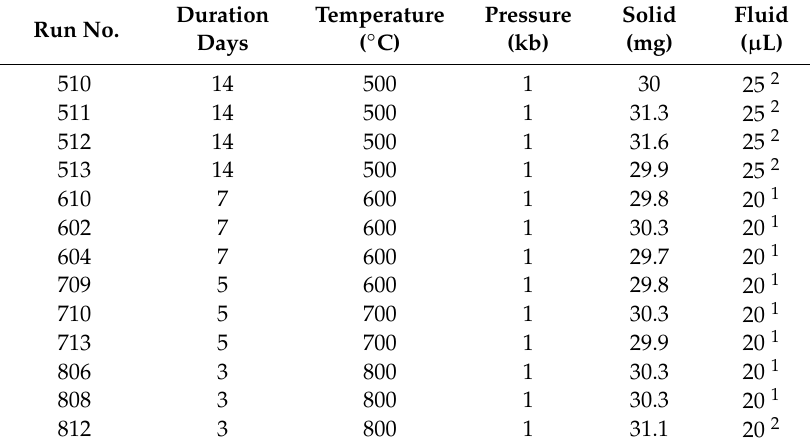
Table 1. Experimental conditions in the MnS–(Ni, Mg, Co, Zn, Fe)Cl 2 –H 2 O system. Run